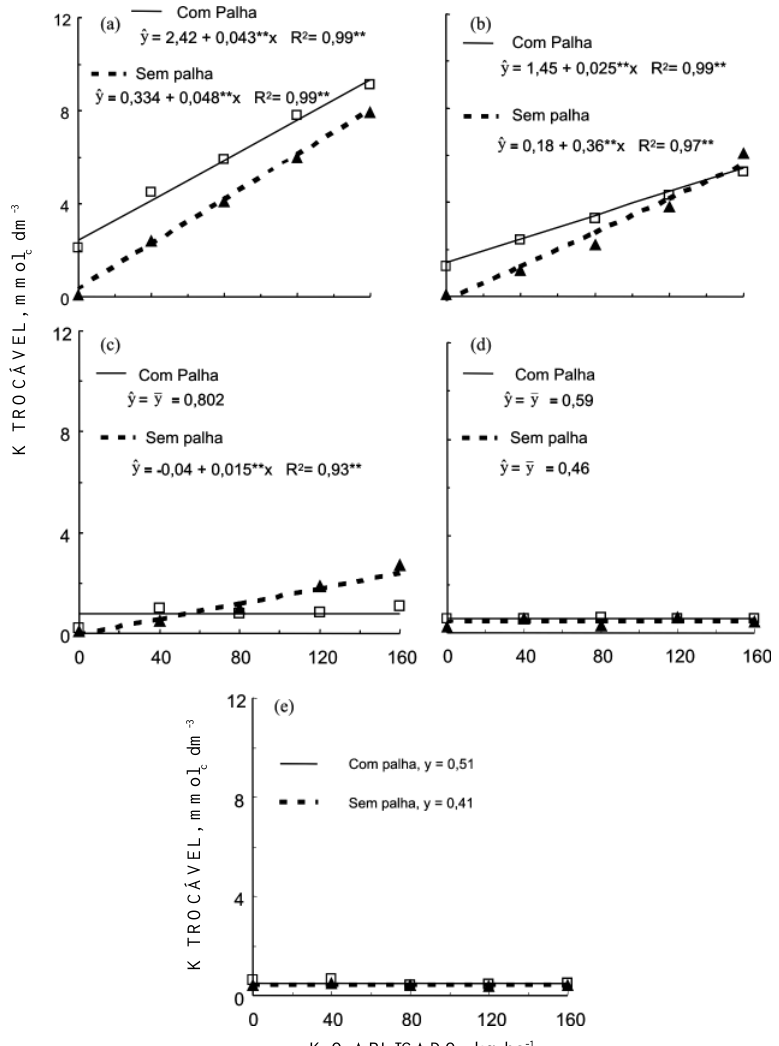
Figura 3. Teores de K trocável em diferentes profundidades (a: 0–2 cm; b: 2–4 cm; c: 4–8 cm; d: 8–12 cm, e: 12–20 cm ) nas cinco doses de adubo aplicadas na ausência ou presença de palha na superfície do solo. (** significativo a 1 % pelo teste